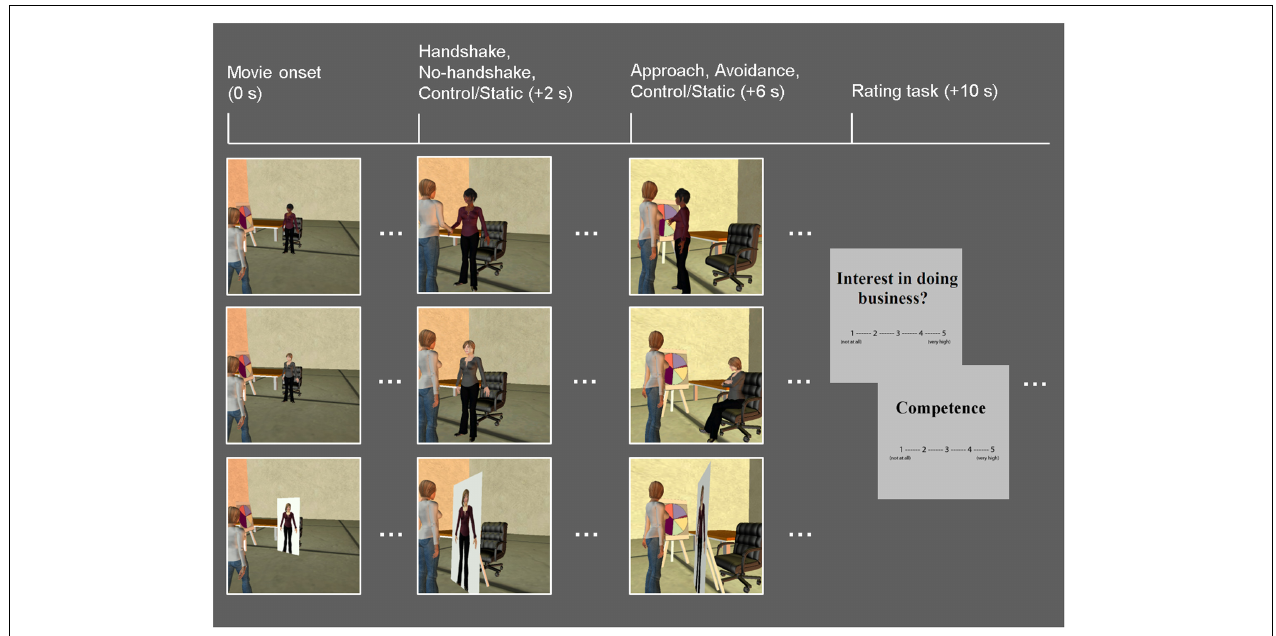
FIGURE 1 | Diagram of the task. Event-related fMRI data were recorded while participants viewed movies of guest–host interactions, in which hosts displayed dynamic non-verbal behaviors that either encourage (approach: open postures, smiley faces; top row) or discourage (avoidance: closed postures, frowny faces; middle row) further social interaction. A static social scene condition, in which the host characters were replaced with cardboard cutouts depicting their whole body, was used as a control condition (bottom row). Half of the dynamic social interaction trials involved a handshake; both the dynamic and static conditions were followed by participants’ ratings of the hosts on competence as business representatives, and their own interest in doing business with the hosts. Time (in seconds) denoted in parentheses above specifies the onset of each event relative to that of each movie.